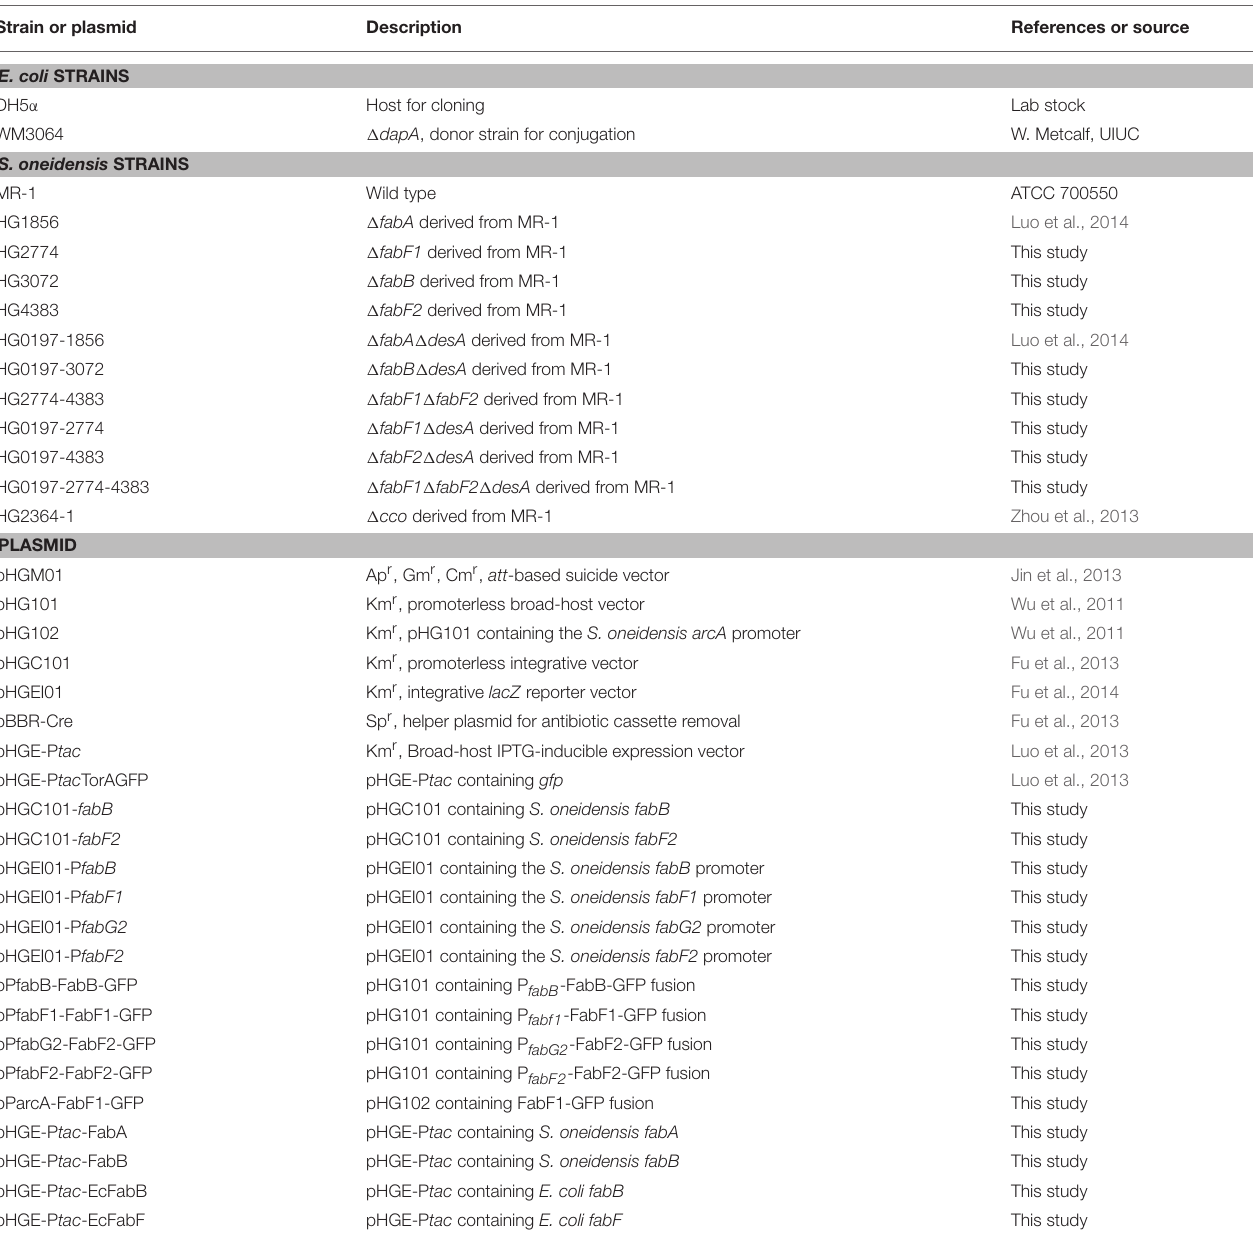
TABLE 1 | Strains and plasmids used in this